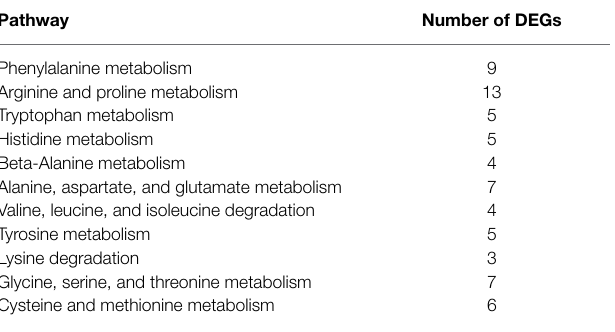
TABLE 5 | Summary of DEGs involved in amino acid metabolism.